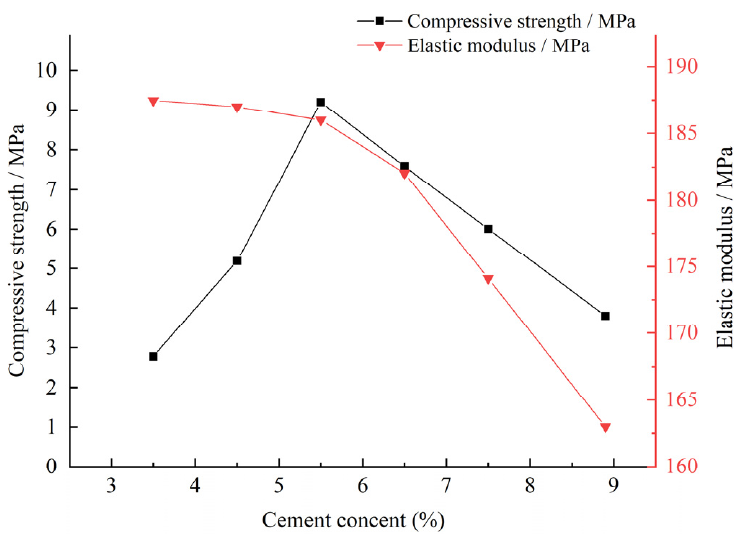
Figure 6. Curves of the compressive strength and elastic modulus at different cementing agent contents.